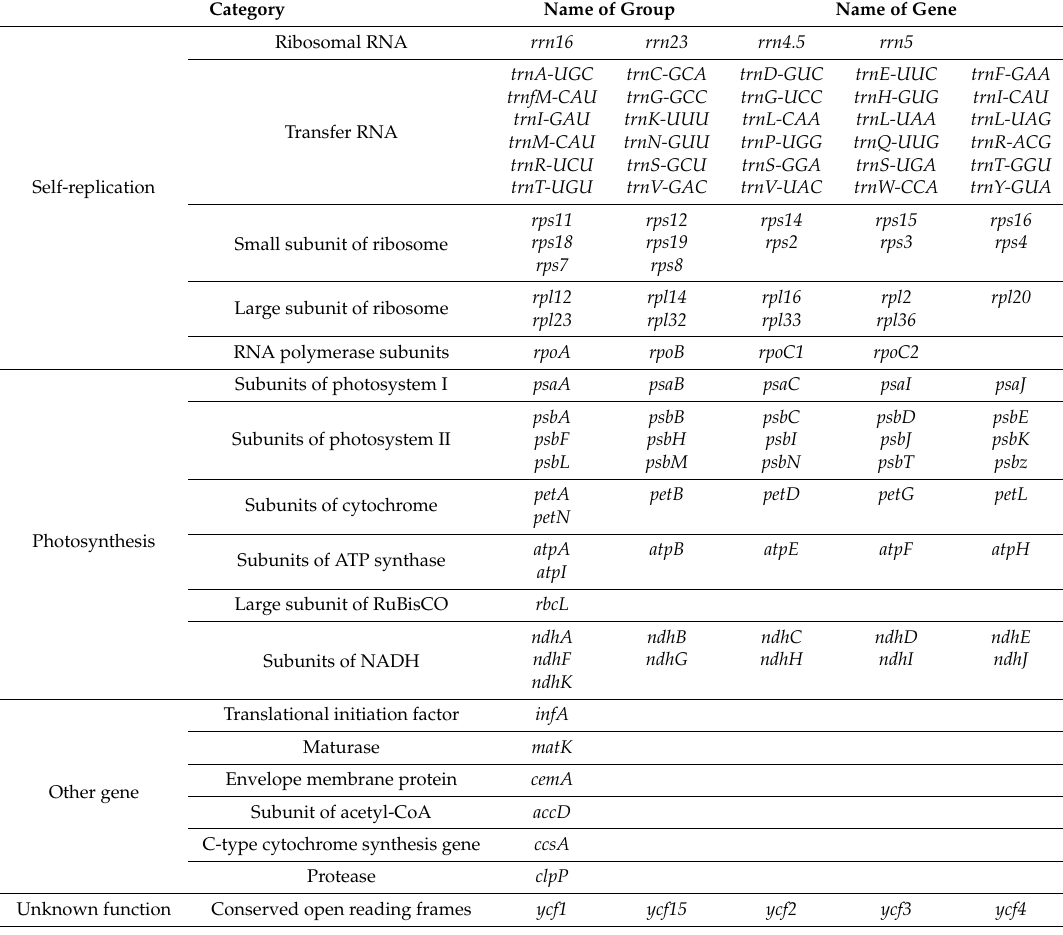
Table 1. List of genes annotated in the plastomes of M. zenii sequenced in this